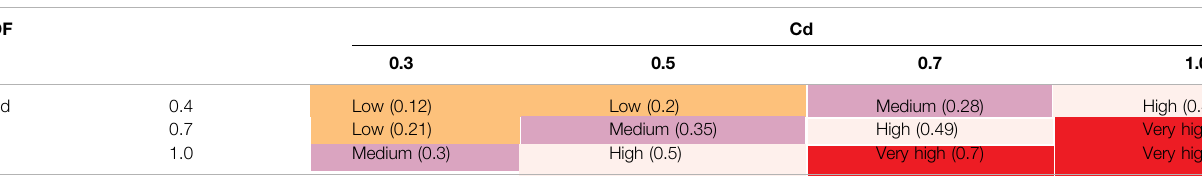
TABLE 3 | Debris factor hazard